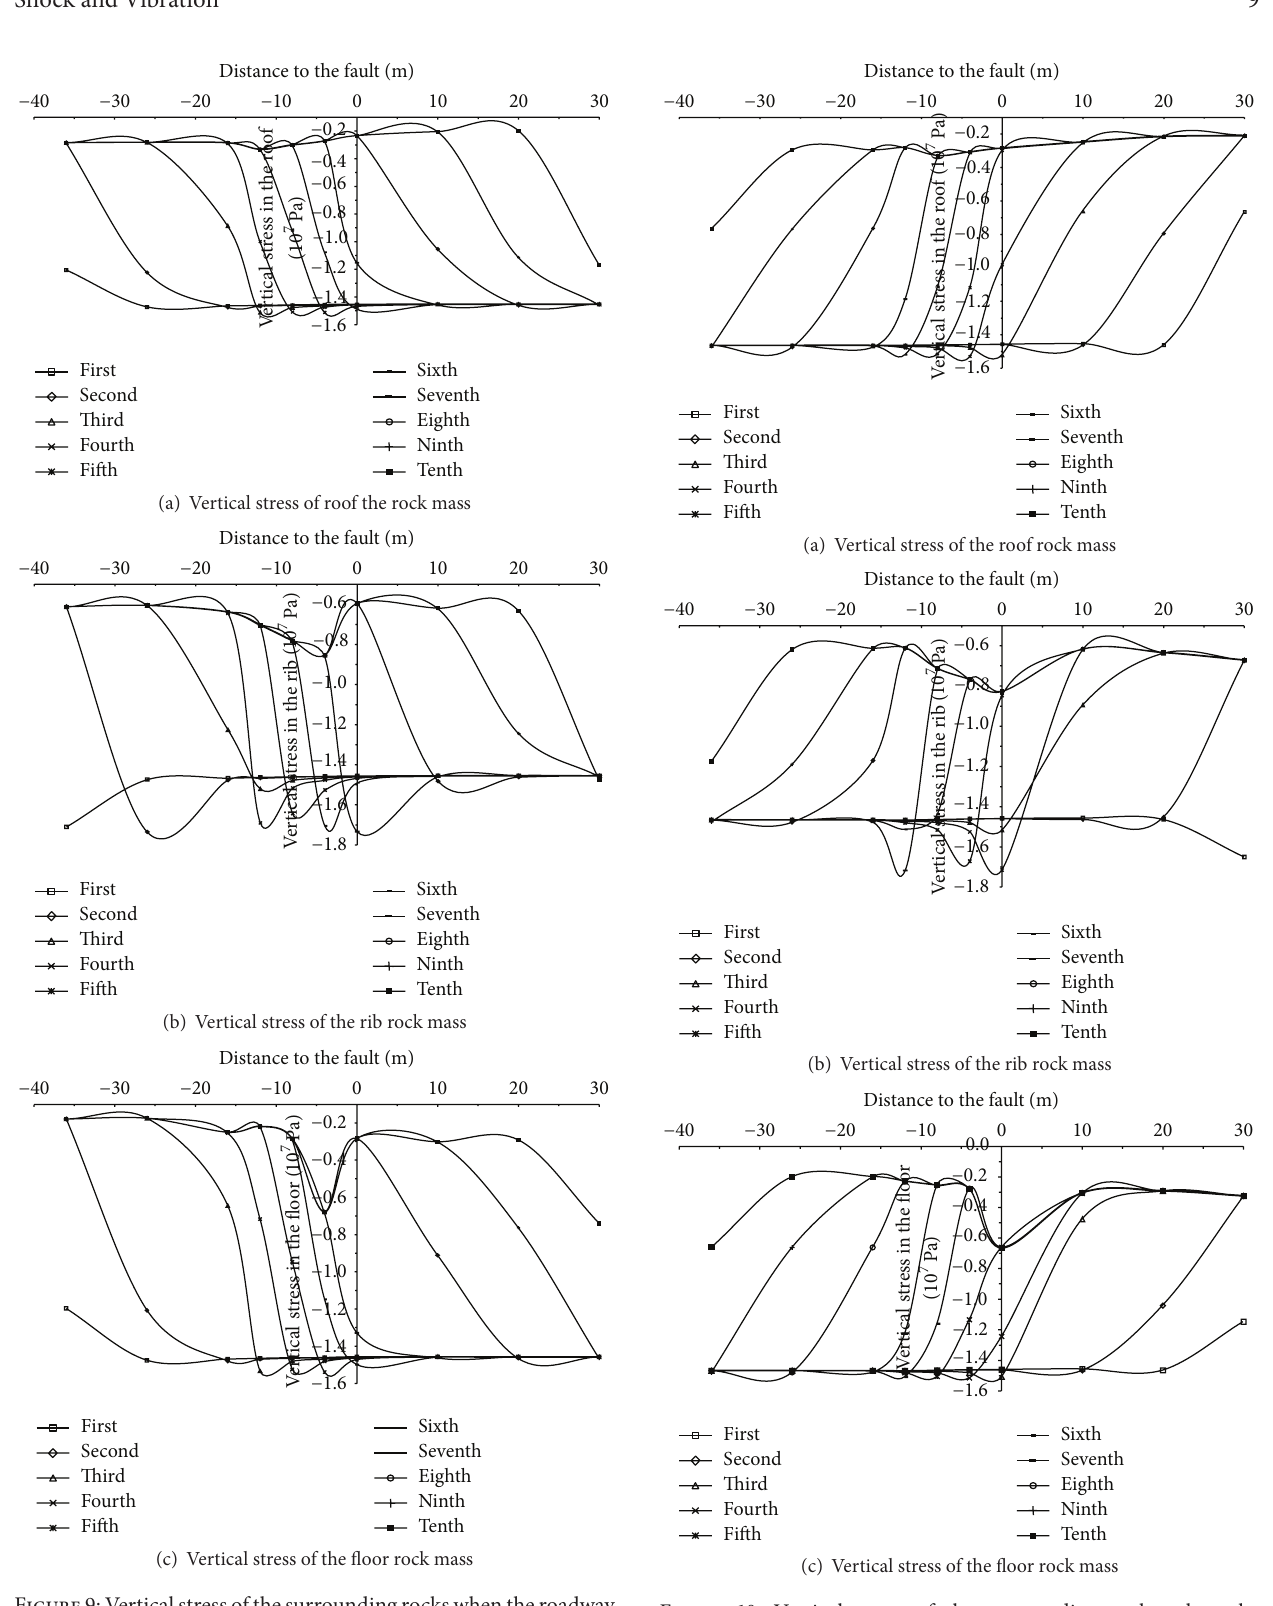
Figure 10: Vertical stress of the surrounding rocks when the roadway passes from the foot wall to the hanging wall of the fault. Note: first to tenth denotes the excavation